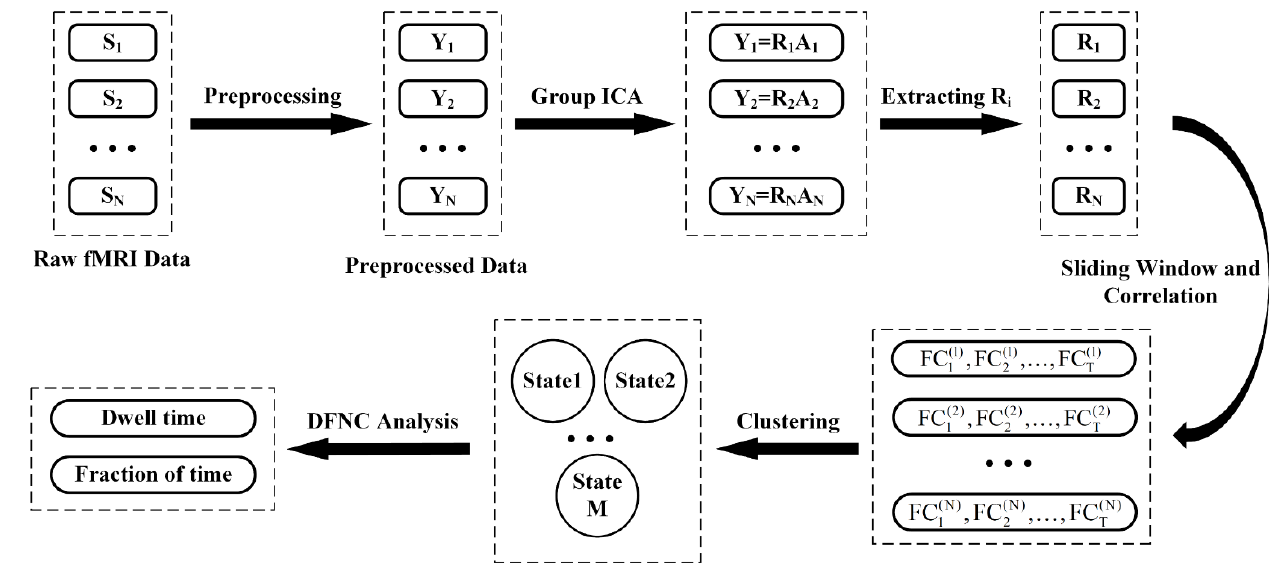
Figure 2. The overview of the framework of DFNC processing. S i represents the raw fMRI data of the i th subject. Y i repre- sents the preprocessed fMRI data of the i th subject. R i represents the mixing matrix (time courses) and A i represents the source matrix (independent components) of the i th subject. FC j(i) represents the FC pattern of the j th sliding window of the i th subject.